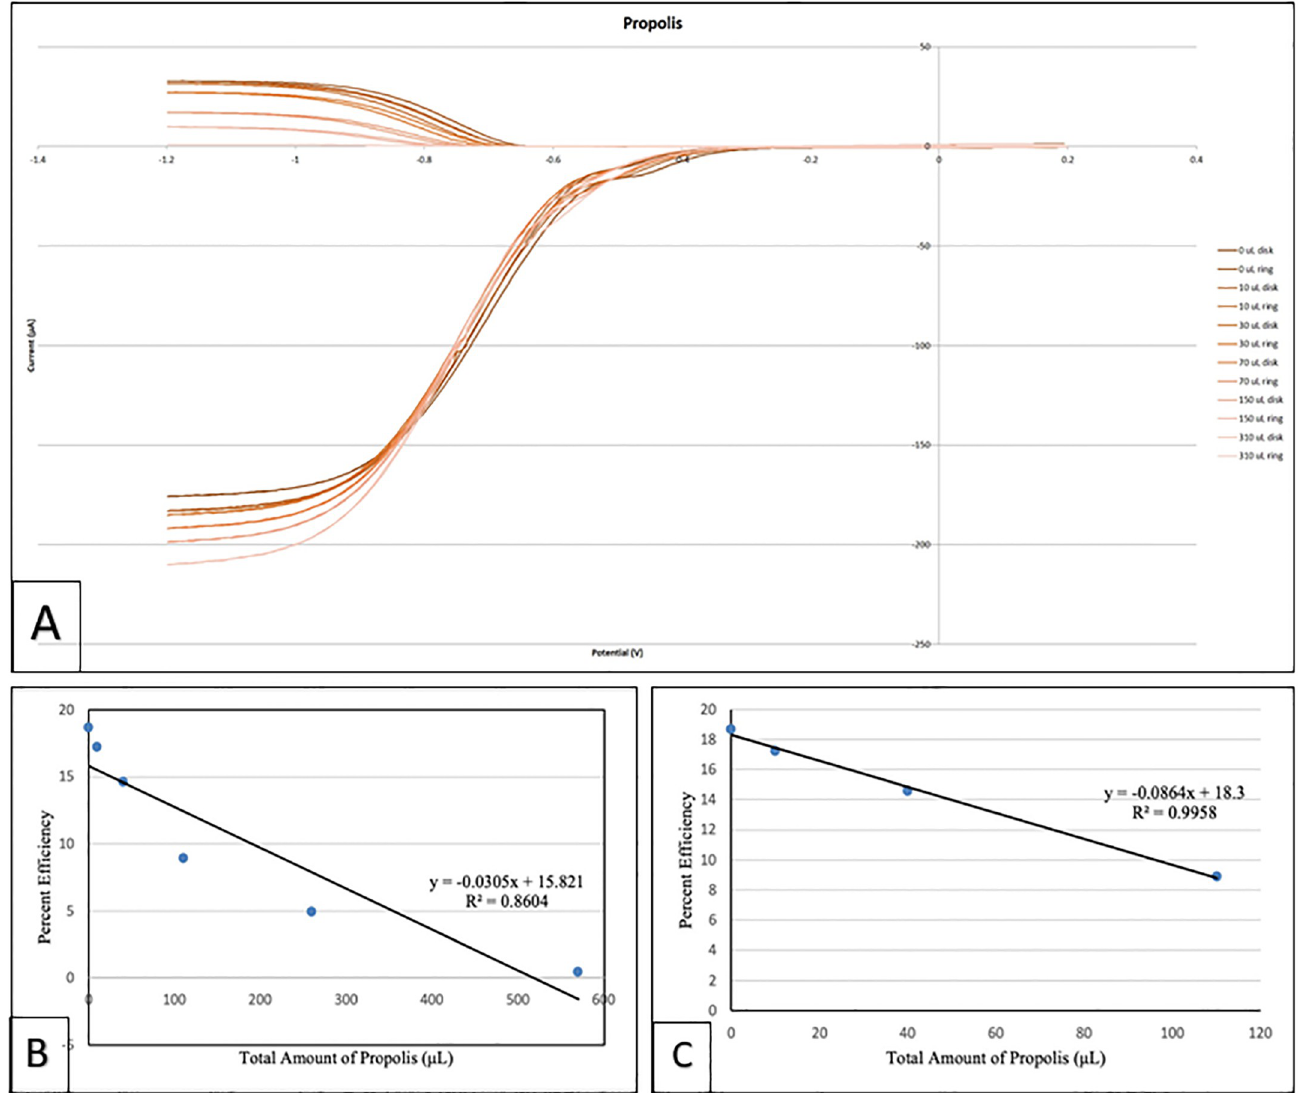
Fig 11. A: Cyclovoltammograms of propolis when scavenging the superoxide radical, B: Collection efficiency of propolis; linear behavior considering all runs. The last run shows almost complete elimination of superoxide; C: Linear behavior of propolis considering the first 4 data on Fig 11A.